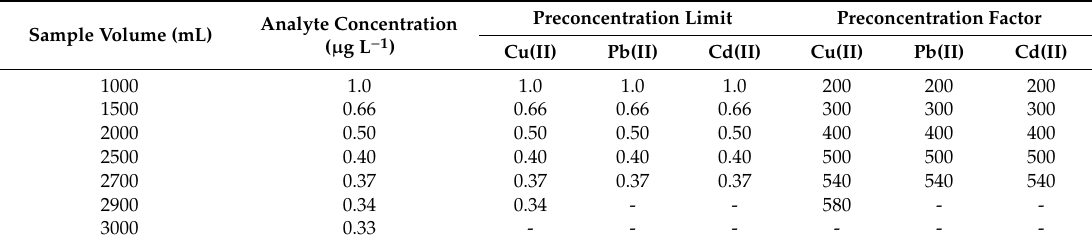
Table 6. Preconcentration studies data for APBC packed column (column parameters: M n + = 1.0 µ